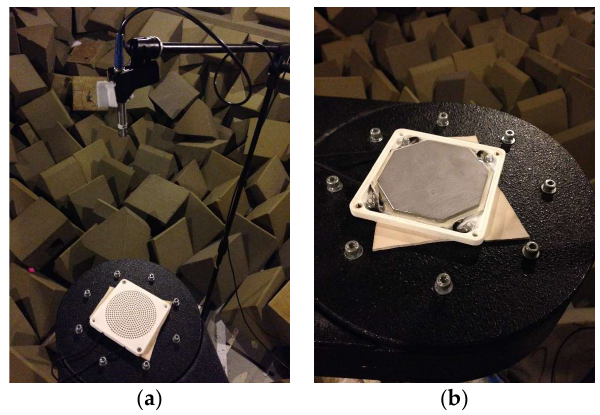
Figure 8. On-axis measurements in the semi-anechoic chamber: ( a ) microphone setup; and ( b ) DEAP loudspeaker without enclosure cover and a steel plate used as DEAP loudspeaker diaphragm.